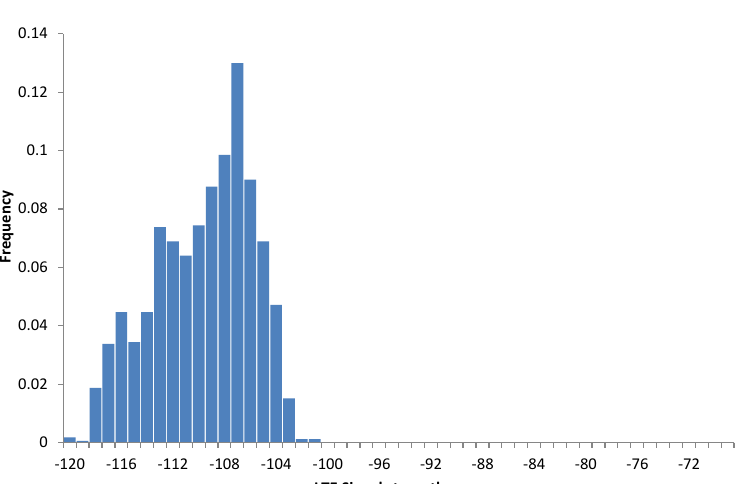
Figure 14. Signal strengths for 10 different locations in the same office room (Experiment 3).